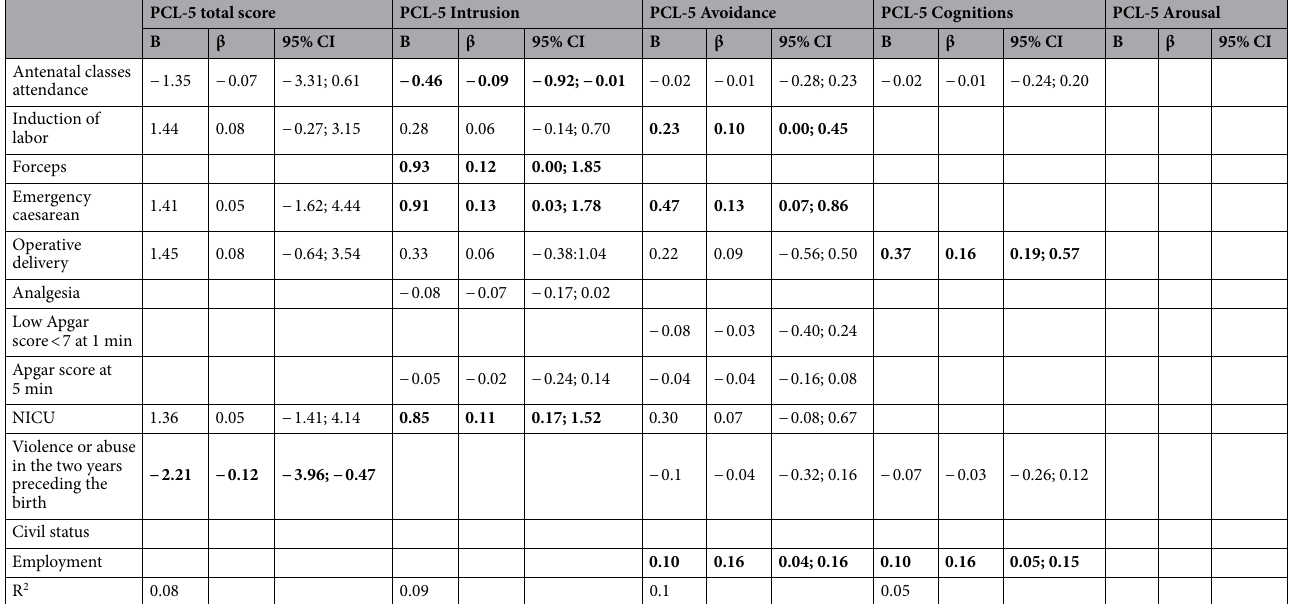
Table 5. Results of multiple linear regression analyses for variables predicting PCL-5. B = unstandardized regression coefficient; β = standardized regression coefficient; 95% CI = 95% bias corrected and accelerated confidence intervals of unstandardized regression coefficient as estimated by means of bootstrapping. Bold regression coefficients are significantly different from 0 ( p < .05). PCL-5 = Posttraumatic Stress Disorder Checklist for DSM